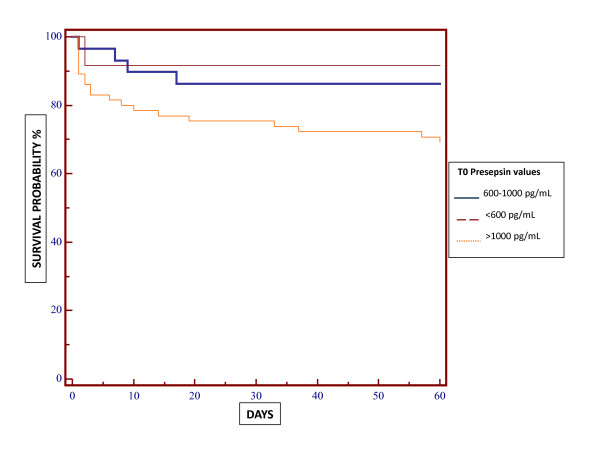
Kaplan-Meier graph showing correlation between initial values (time 0) of presepsin and survival in patients with sepsis, severe sepsis and septic shock. Sixty-day in-hospital mortality was higher in patients with initial values of presepsin greater than 1,000 pg/ml than in groups with lower values (P = 0.04).